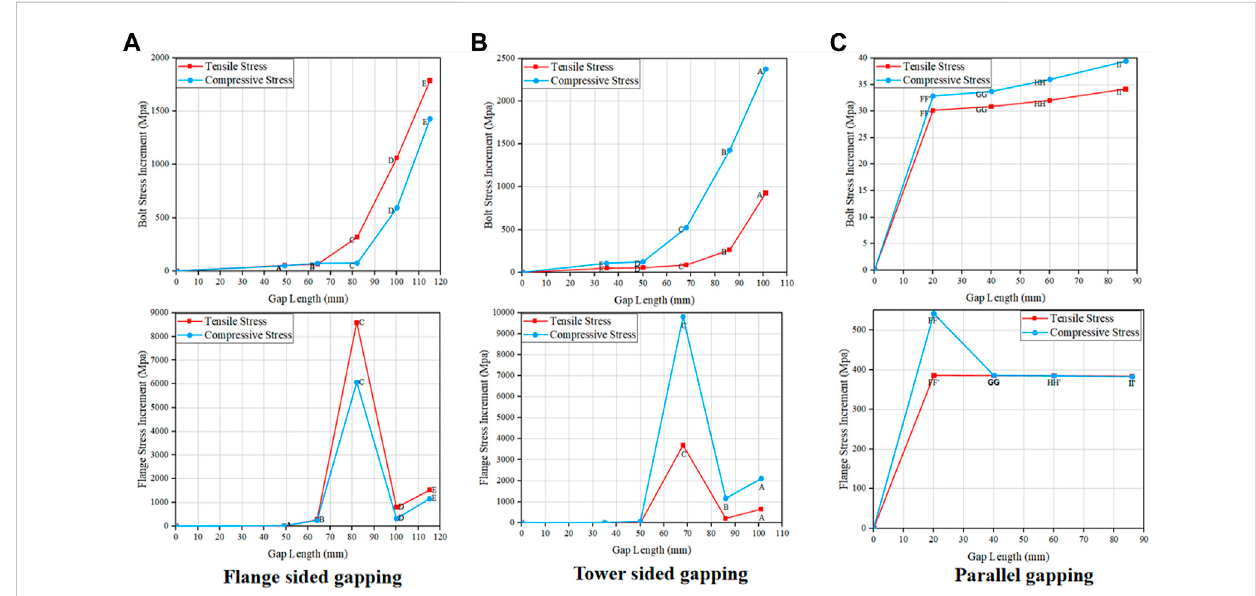
FIGURE 12 Stress increment of the FOWTs ’ tower bolts and fl anges under fl atness divergence. (A) Under fl ange sided gapping. (B) Under tower sided gapping. (C) Under parallel gapping (details of the location of openings are given in Figure